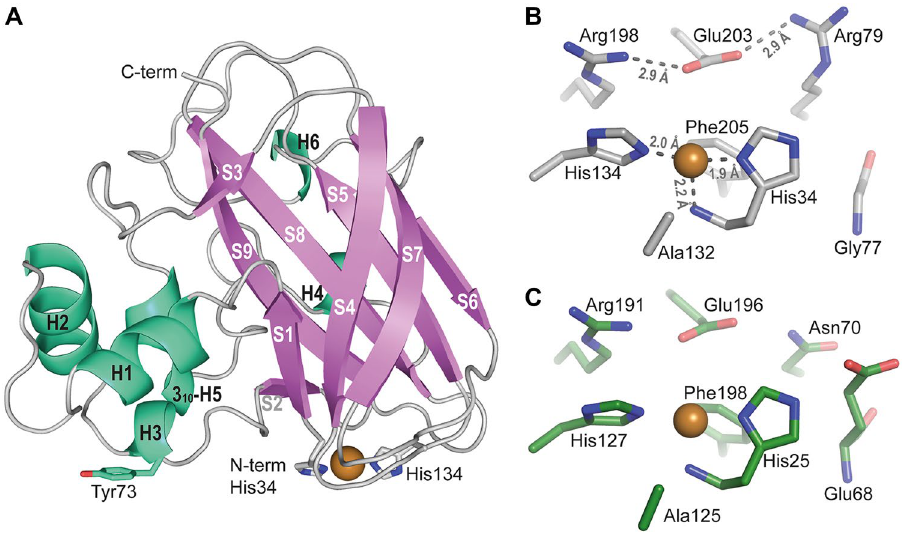
Figure 3. Three-dimensional structure of Sc LPMO10D CD . ( A ) Shows a cartoon representation of the catalytic domain, highlighting secondary structure elements (PDB 7ZJB). The six α-helices (including one 3 10 helix; H5) are labelled H1-H6 and are colored cyan-green; strands are labelled S1-S9 and are colored violet. The copper atom is shown as an orange sphere and is coordinated by two histidines, N-terminal His34 and His134, shown with stick representation. Tyr73 is also shown with stick representation as it is known to be important for substrate binding in several characterized LPMO10s 45,46 . ( B ) Shows a close-up view of the catalytic center and displays the distances between the ligands and the copper cofactor in Ångström (Å). Conserved secondary sphere residues Ala132 and Phe205, which help in shaping the copper site, are also shown, as well as the unusual Arg198-Glu203-Arg79 arrangement. For comparison, ( C ) shows the catalytic center of the closest structurally characterized homologue of Sc LPMO10D, Tm LPMO10A (also known as Tma12), which is predicted to be chitin-active and lacks this Arg-Glu-Arg